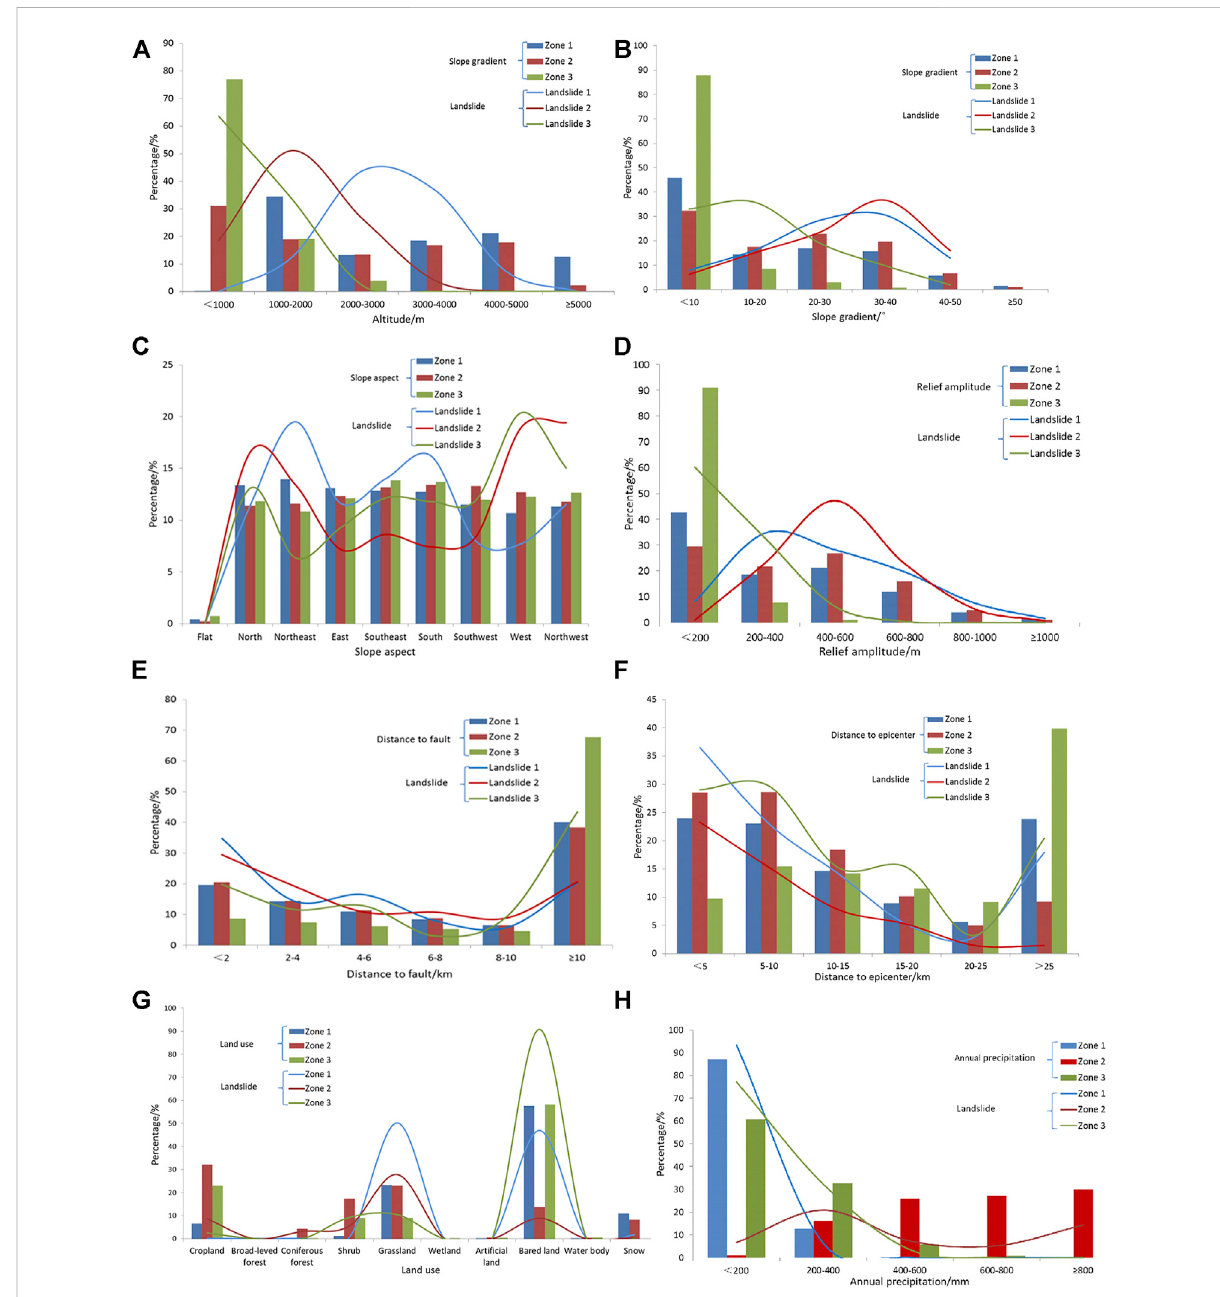
FIGURE 5 Classi fi cationofdifferentfactorsanddistributionoflandslidesineachzone[ (A) altitude; (B) slopegradient; (C) slopeaspect; (D) reliefamplitude; (E) distance to fault; (F) distance to epicenter; (G) land use; and (H) annual